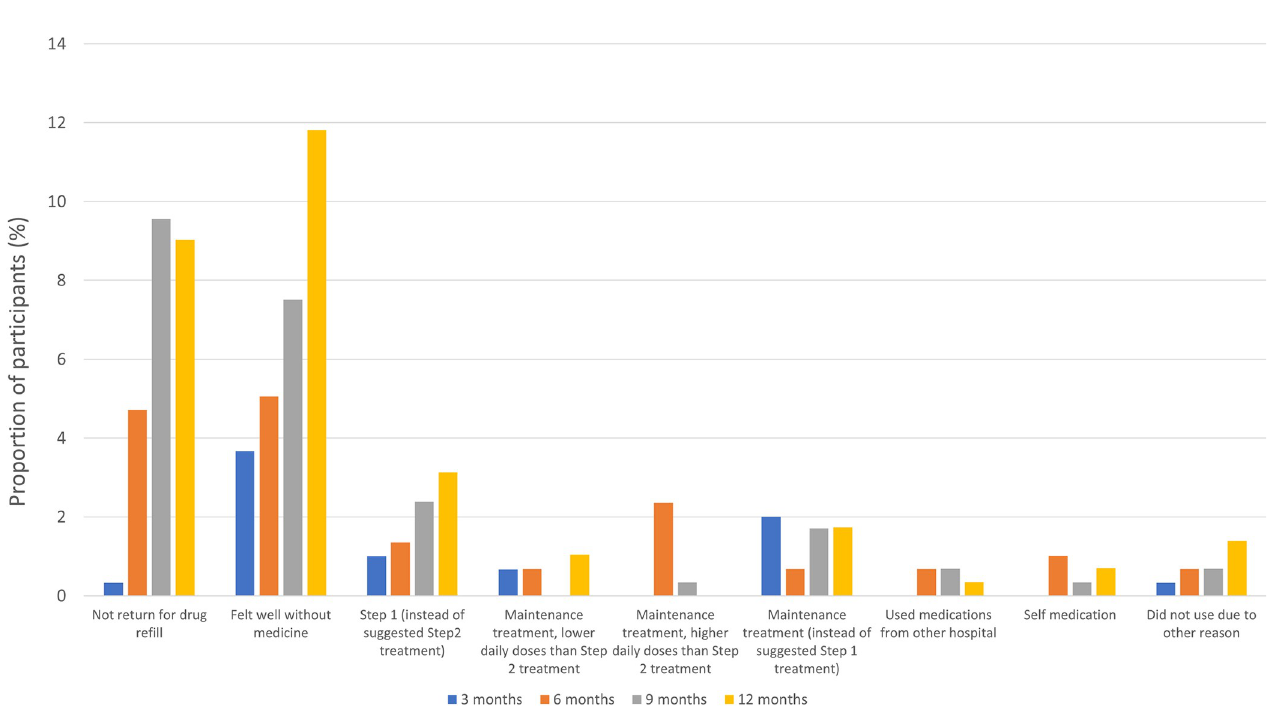
Fig 4. Patterns of nonadherence to treatment.